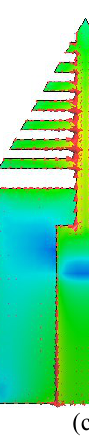
Figure 7: Simulated current distributions of the LPMA at (a) 5 GHz (b) 5.8 GHz (c)7